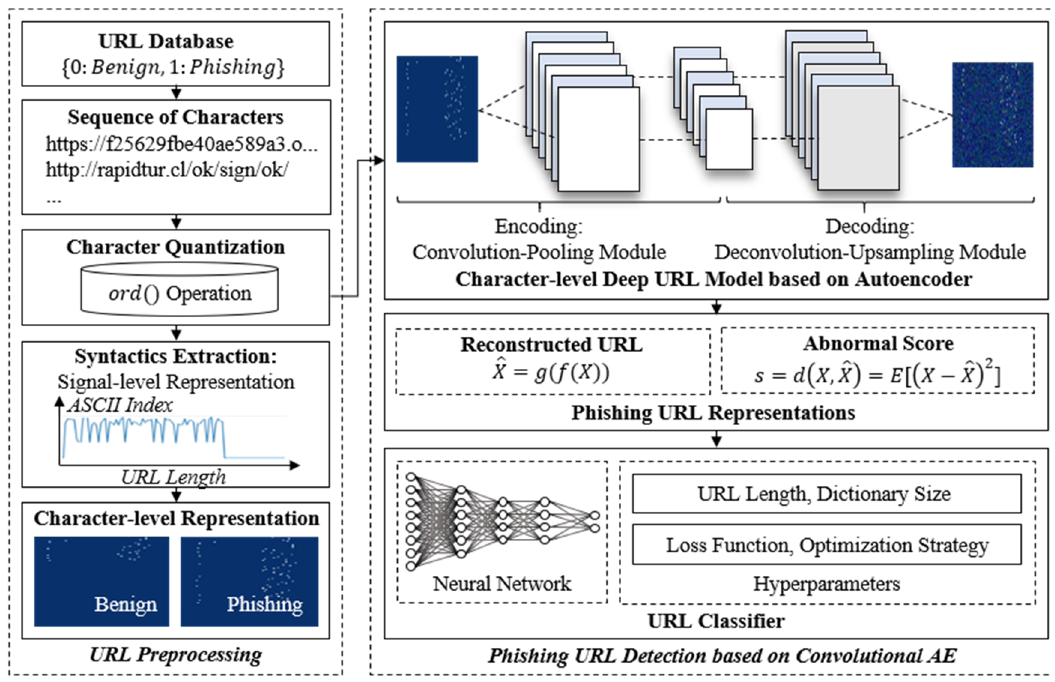
Figure 3. Two major components for phishing URL detection: a convolutional autoencoder for constructing a deep URL model and an auxiliary convolutional neural network for learning the threshold function.